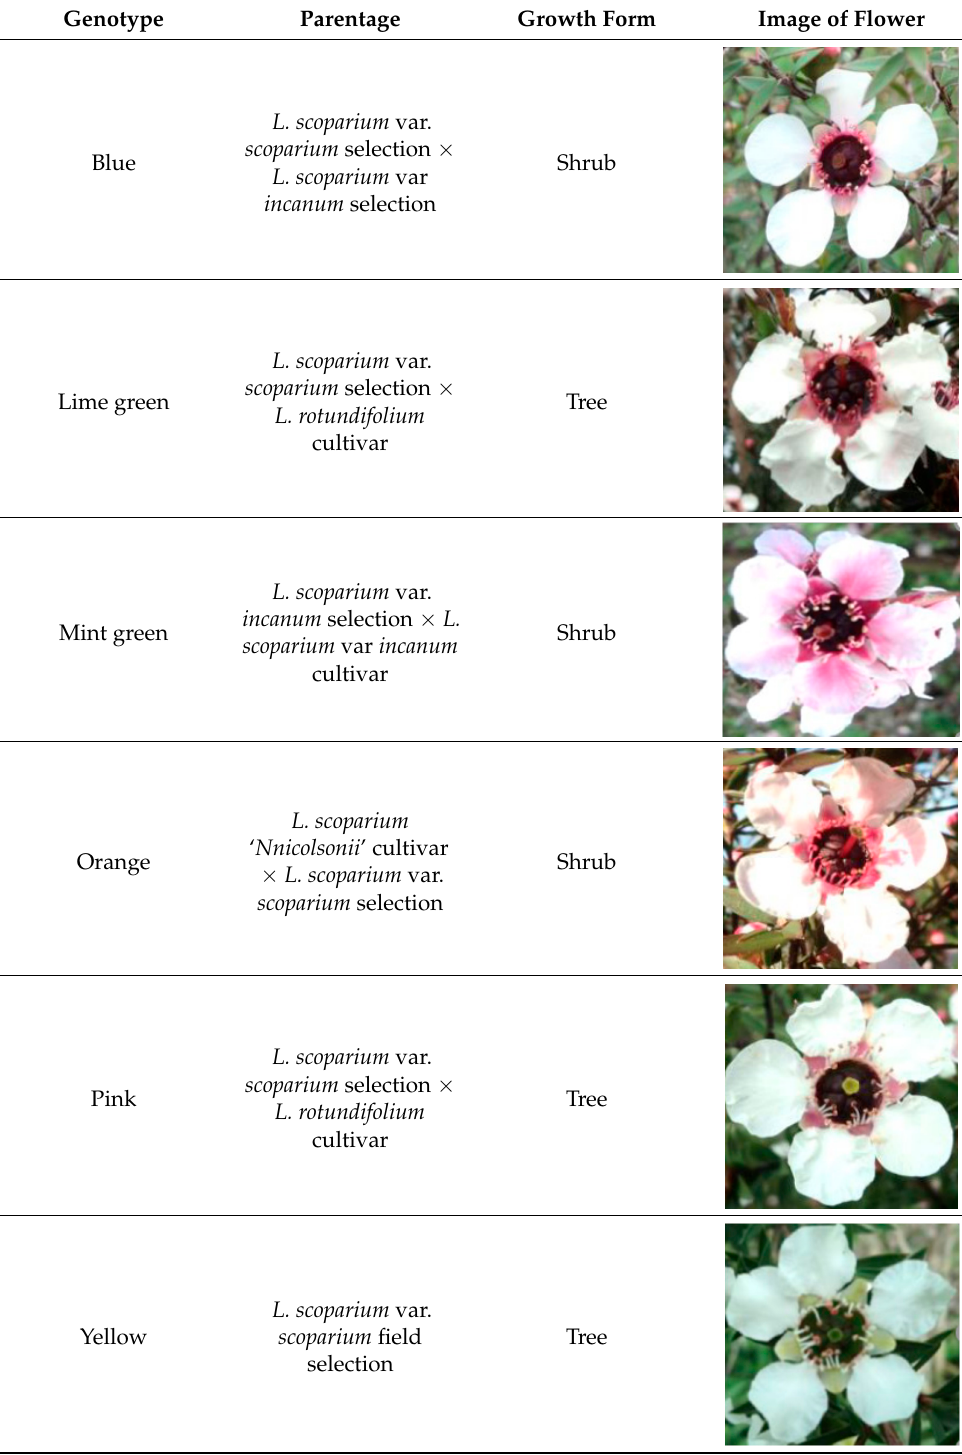
Table 1. Characteristics of the m ā nuka clonal genotypes used in this study. Photo credit: Julia Bohór- quez Rodríguez de Medina.